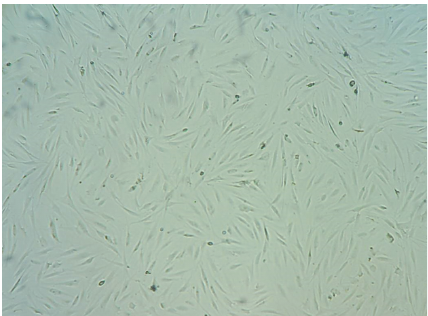
Figure 1: Phase-contrast microscopic image showing spindle shaped MSCs ( ×